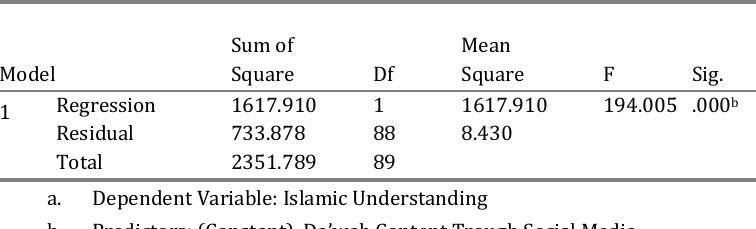
Table 9 Model Feasibility Test Calculation Results (F